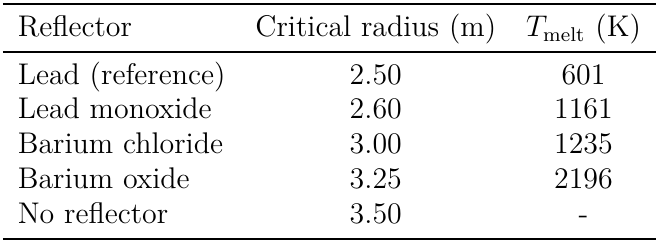
Table IV: Reflectors considered at